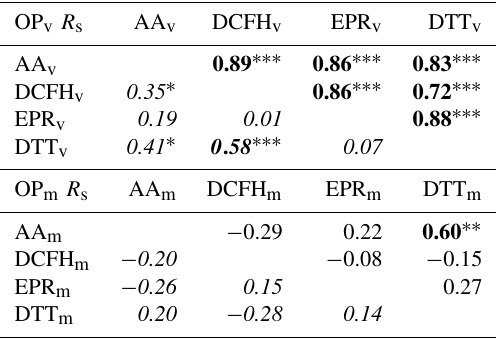
Table 1. Correlation of volume-normalised (OP v , top panel) and mass-normalised (OP m , bottom panel) assay responses in the win- ter (upper right values, regular font) and summer (lower left val- ues, italic font) campaign. It should be noted that assay responses expressed as mass-normalised (OP per µg) are correlated with mass-normalised additional particle-phase composition measure- ments (i.e. µg or ng per µgPM 2 . 5 ). OP v R